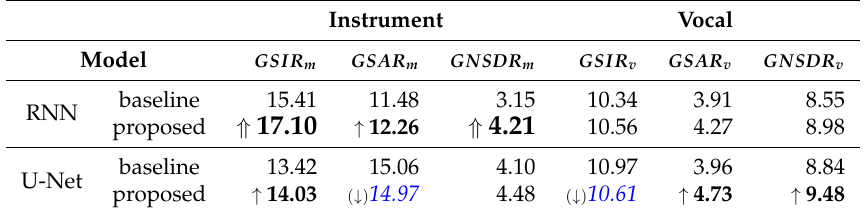
Table 4. Separation performance comparison for MUSDB18 dataset. Notations are same as in Table 2. Instrument